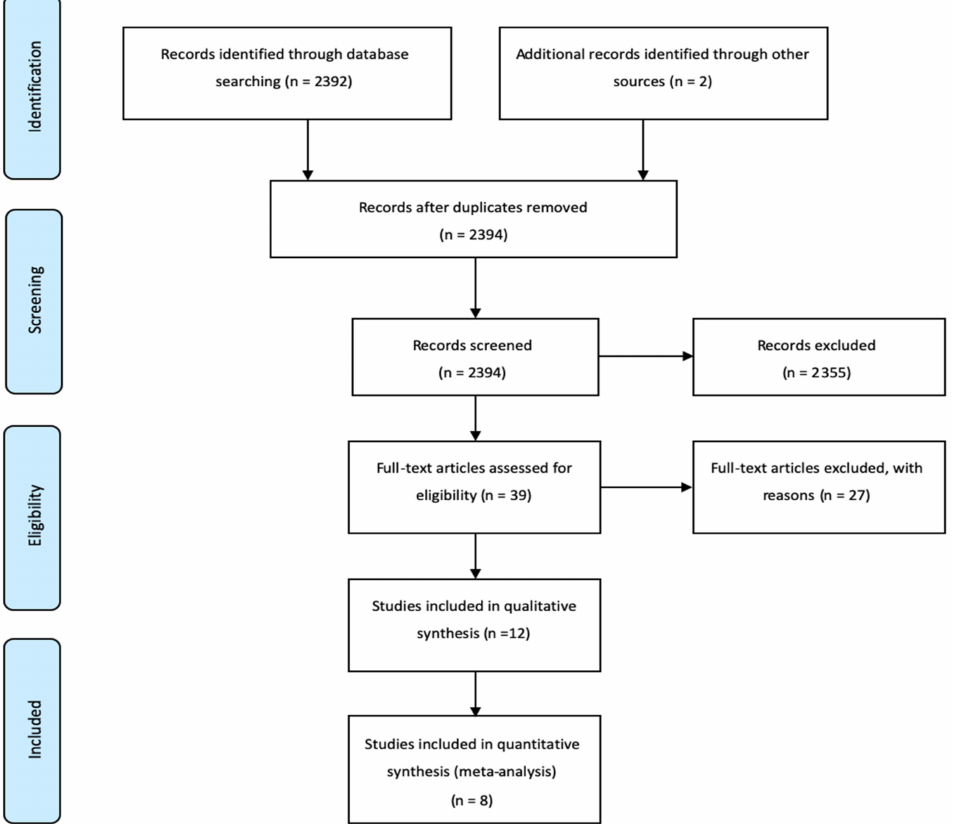
Figure 1. The selection process for the systematic review and